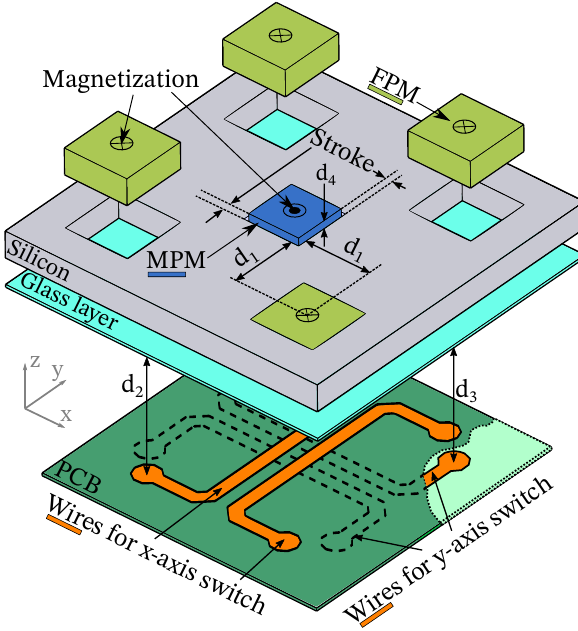
Figure 1. Elementary Digital Actuator